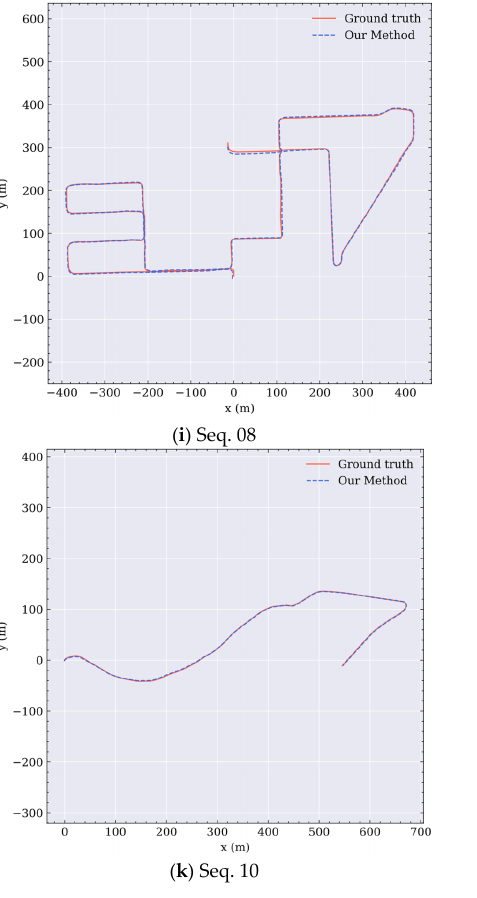
Figure A1. Prediction trajectories and ground truth of each sequence in the KITTI dataset.